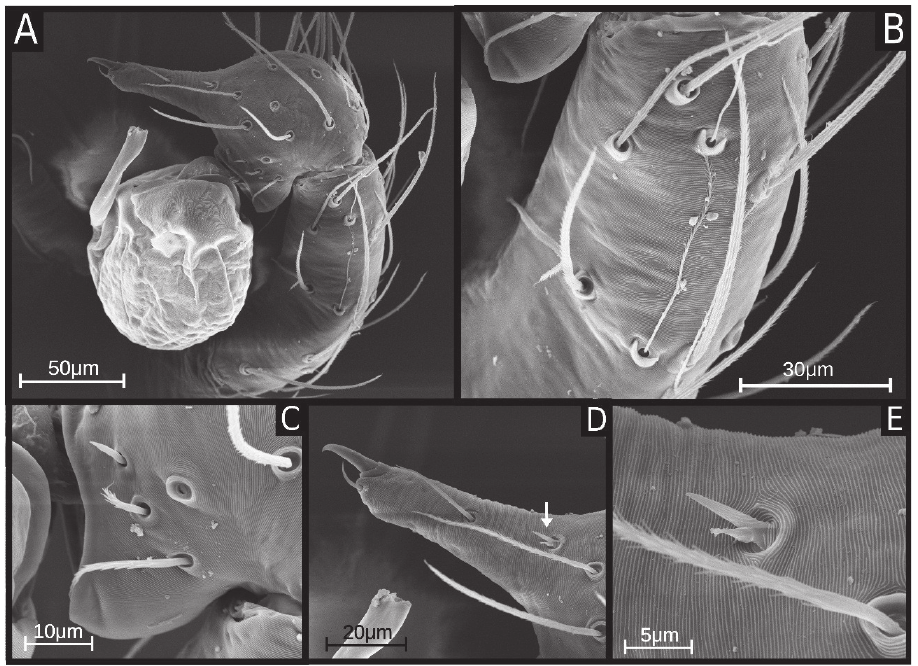
Figure 8. SEM images of Ochyrocera magali sp. nov., male palp (IBSP 188946) A cymbium and bulb, retrolateral view B palpal tibiae, retrolateral view C cymbium, distal area, retrolateral view D cymbial extension, retrolateral view, arrow indicating the tarsal organ E cymbium, tarsal organ,